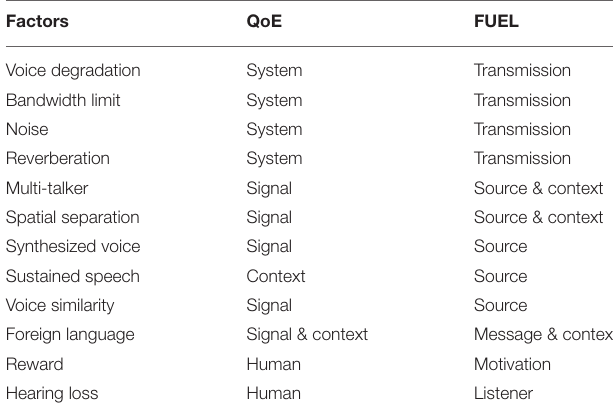
TABLE 1 | Sources of listening effort and their corresponding influencing factor categories in the QoE framework and the FUEL.